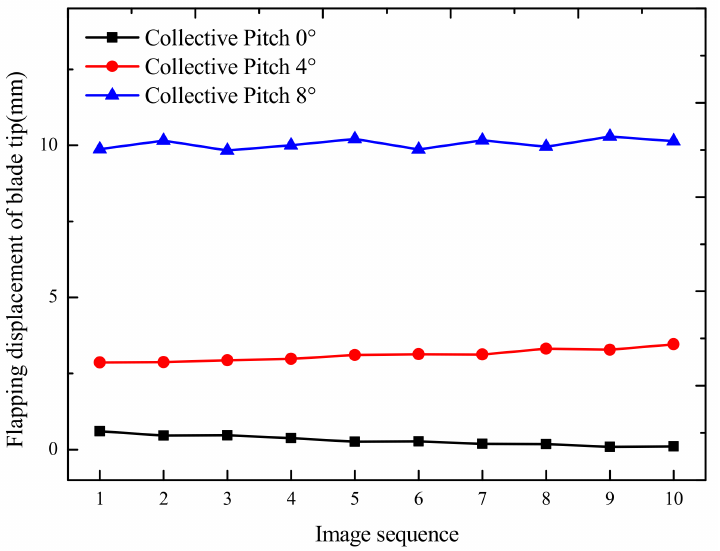
Figure 15. Blade tip displacements at three different collective pitch angles in hover flight.